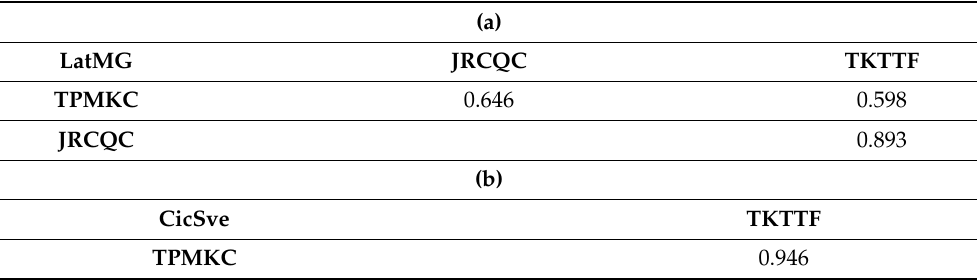
Table 3. Correlation analysis between reaction profile of: (a) LatMG RILs against the three considered races: TPMKC, JRCQC, and TKTTF, and (b) CicSve RILS against the two races TPMKC and TFTTF. Pearson correlation R values are reported. All reported correlation values are significant at p <